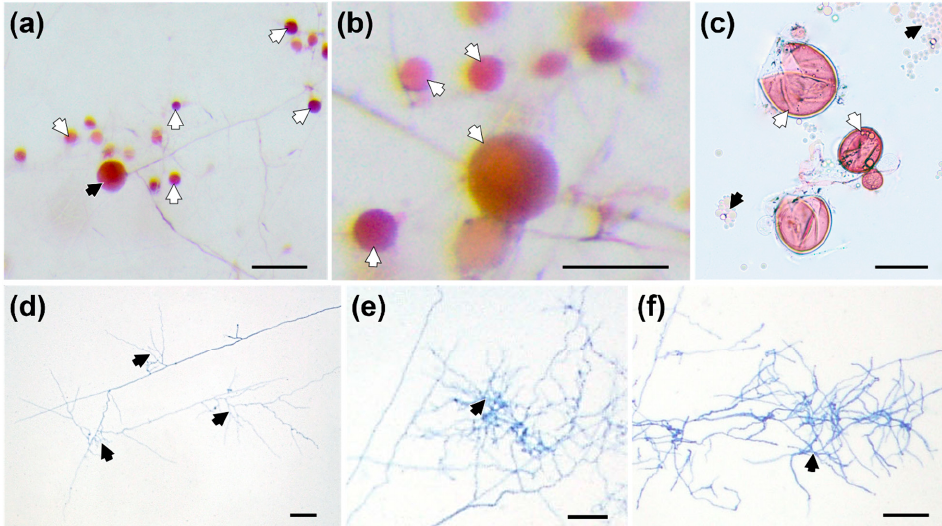
Figure 2. Secondary spores (indicated by white arrowheads) stained with the tetrazolium chloride vital stain INT to show their viability. The contents of viable spores are stained red ( a – c ). The black arrowhead in ( a ) indicates the germinating mother spore; the black arrowheads in ( c ) indicate lipids of crushed secondary spores. Germinated spores with branch absorbing structures (BAS, indicated by black arrowheads) ( d – f ). Scale bars in ( a – c ) represent 200 µm, 100 µm and 50 µm, respectively; scale bars in ( d – f ) represent 20 µm. Only a few SS germinated (<10%), and the hyphal growth of germinated SS was lim- ited compared with that of the well-developed spores (Figure 3a,b). After coculture for three months, less than 20% of plants were colonized by SS, and few intraradical hyphae were observed (Figure 3c). However, more than 80% of plants inoculated with mature spores were successfully colonized and arbuscules were observed within root cortical cells (Figure 3d).